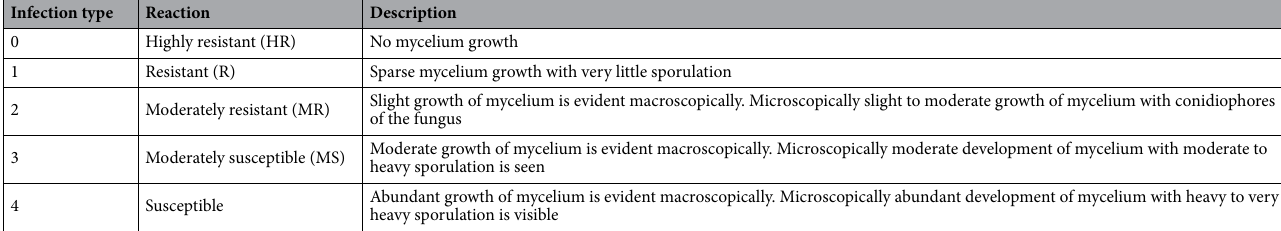
Table 2. Infection types and scoring of powdery mildew disease incidence.